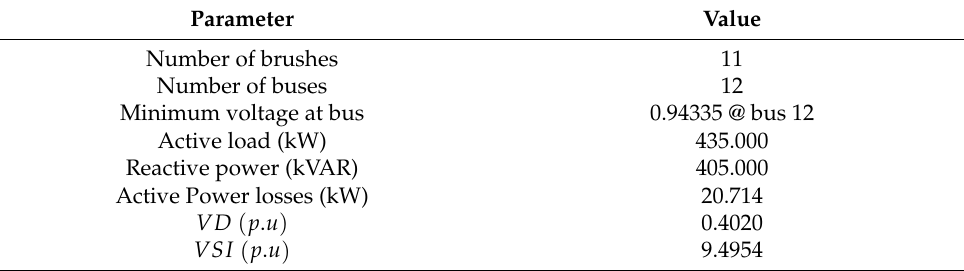
Table 1. The specification of the 12-bus system.